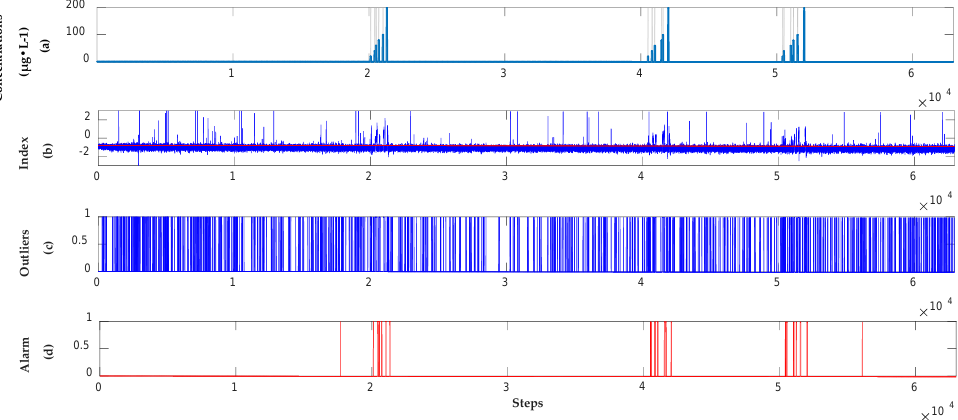
Figure 15. Results of the 23 days’ m-phenylenediamine detection in the semi-supervised model. ( a ) Location and concentration of each event; ( b ) Alarm signals, which exceeded the threshold shown as the red dotted line; ( c ) Outliers obtained by using SVR; ( d ) Alarm sequences triggered by Sequential Bayesian.